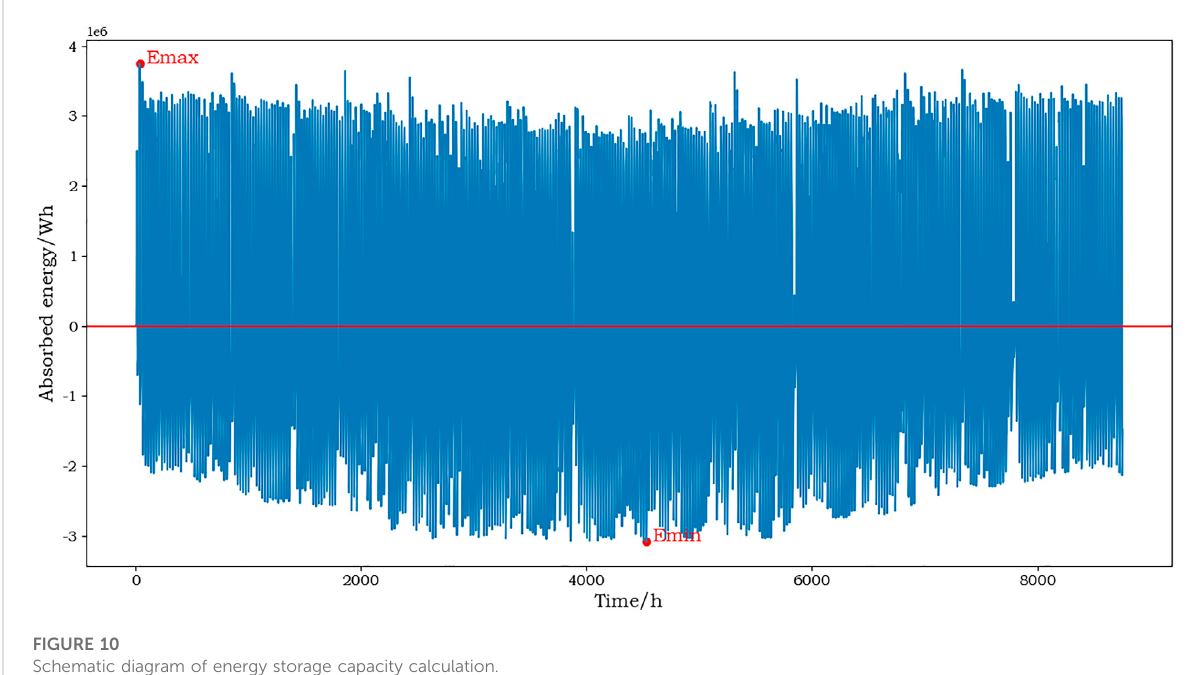
FIGURE 10 Schematic diagram of energy storage capacity calculation.